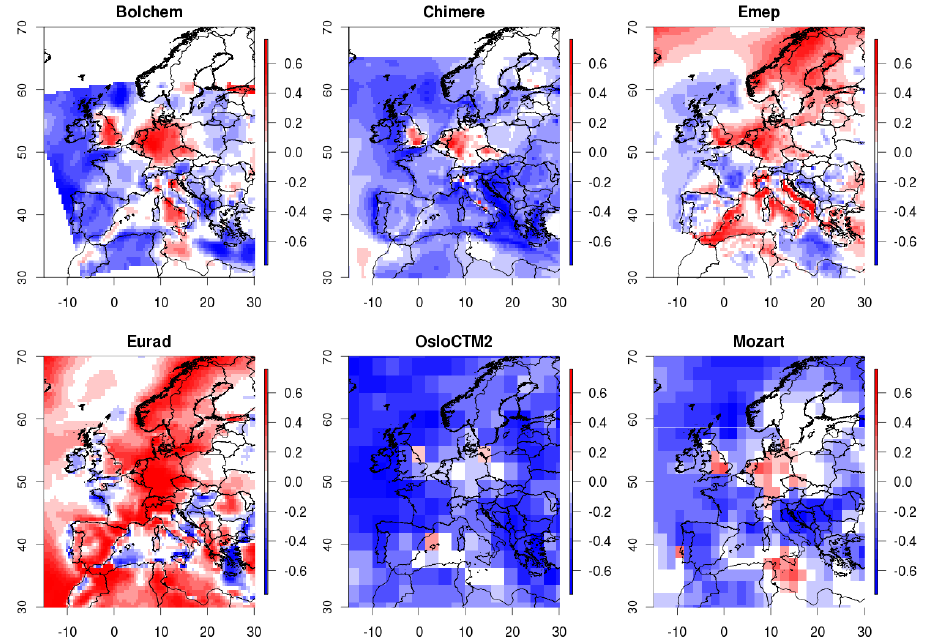
Figure 9 : Same as Figure 7 for O 3 . Fig. 9. Same as Fig. 7 for O 3